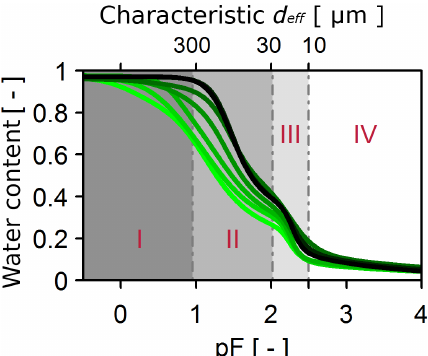
Figure 8. Four pore domains represented in the soil water retention curve. The Roman letters I–III denote different capillary water do- mains for which a detailed explanation is given in the text and values are presented in Table 4. The region denoted by IV is non-capillary (residual)